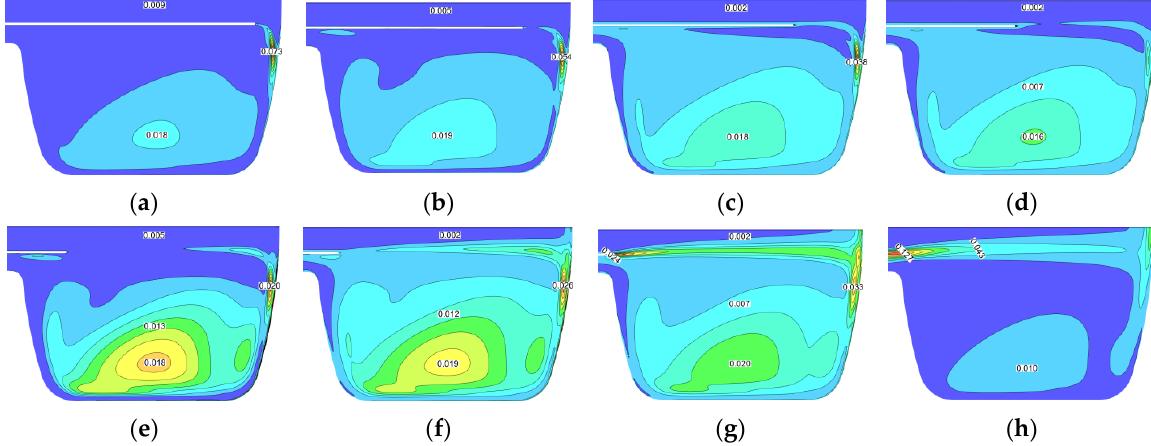
Figure 11. Turbulent kinetic energy distribution in CHM: ( a ) H/D = 0.5; ( b ) H/D = 1; ( c ) H/D = 1.5; ( d ) H/D = 3; ( e ) H/D 4.5; ( f ) H/D = 5; ( g ) H/D = 5.5; ( h ) H/D = 6.